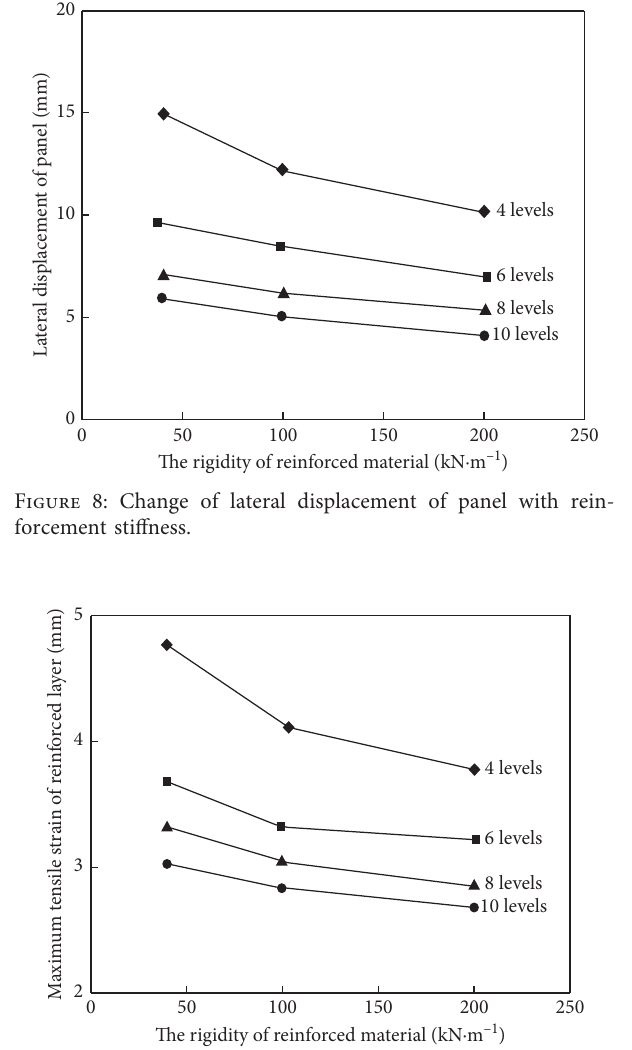
Figure 9: Dependence of maximum tensile strain of the reinforced layer on reinforcement